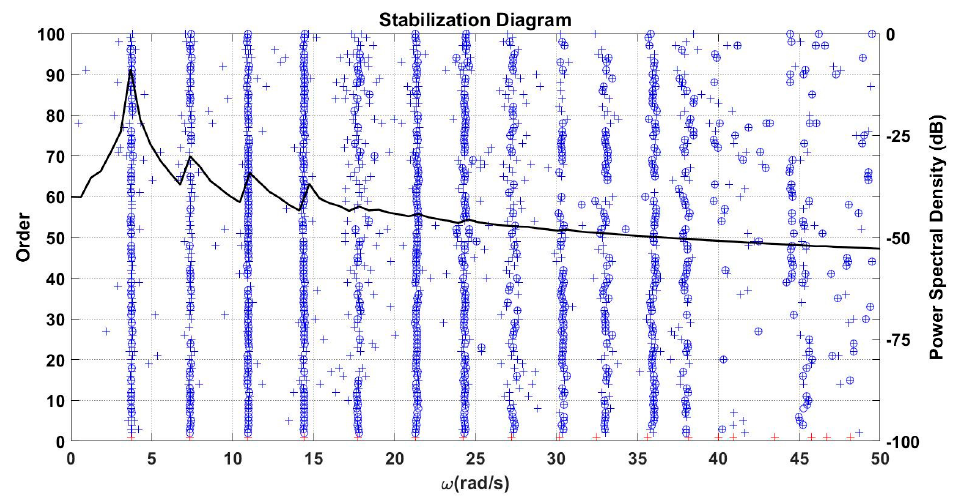
Figure 14. A recorded sample of the Chi-Chi earthquake.